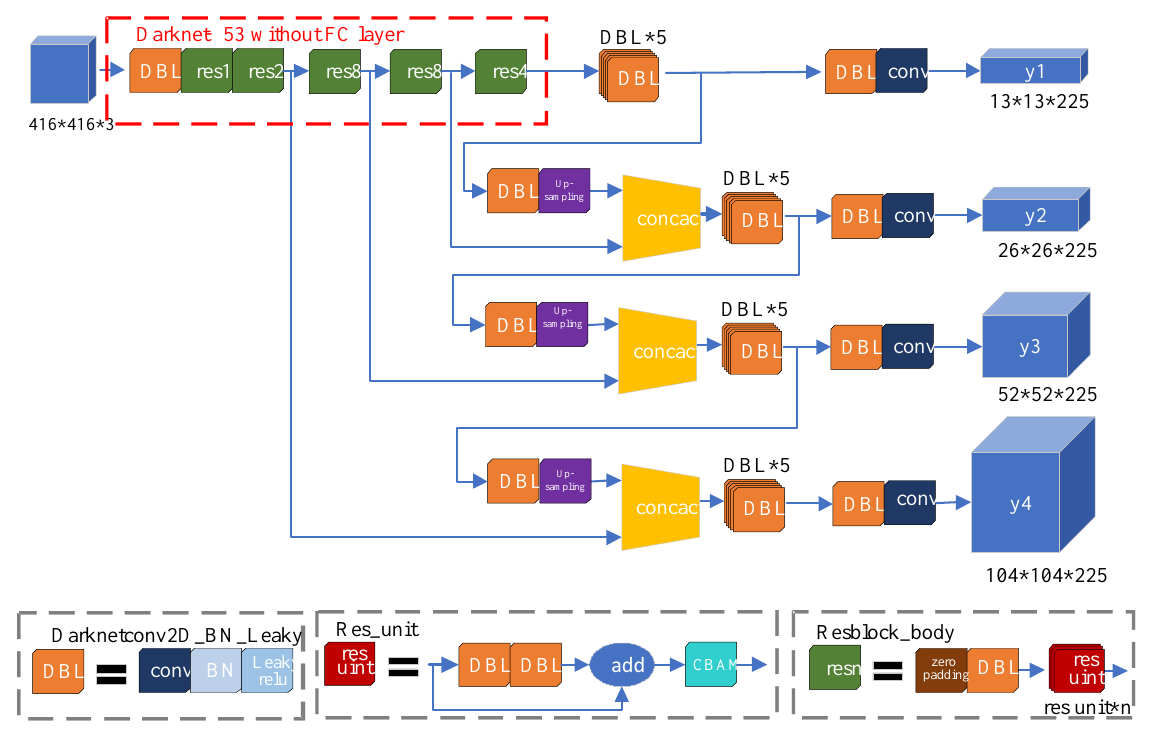
Figure 8. Improved YOLOv3 network structure.